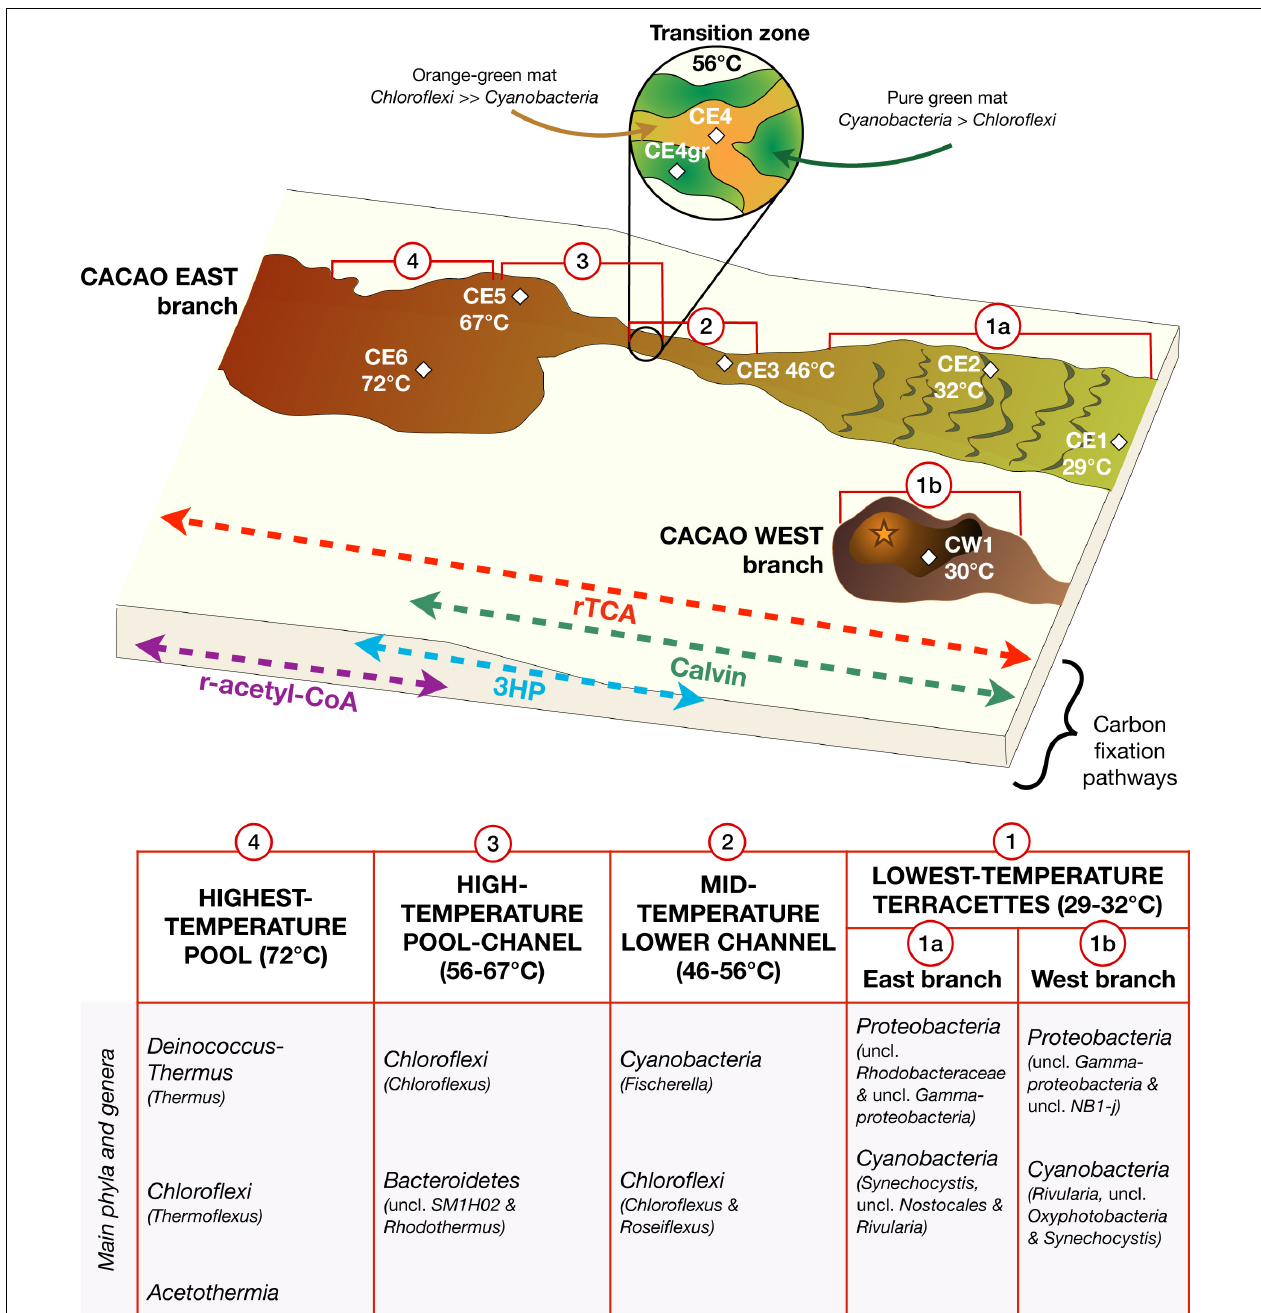
FIGURE 5 | Ecological reconstruction of the microbial community distribution along the Cacao hydrothermal transect based on lipid biomarkers and DNA sequencing. The hydrothermal ecosystem was defined by a succession of microbial community structures and metabolic traits along the temperature gradient, with dominance of thermophilic species at high temperature, of anoxygenic photosynthetic species at intermediate temperatures (67–46 ◦ C), and mesophilic and oxygenic photosynthetic species at low temperature ( ≤ 32 ◦ C). In the channel, the compositional and metabolic transition at 56 ◦ C represented an ecological tipping point where aerobic and anaerobic conditions may alternate (from coexistence of Cyanobacteria and Chloroflexi to dominance of Chloroflexi and from a Chloroflexi community, largely photoheterotrophic to one mostly photoautotrophic). The abbreviation “uncl” means unclassified.